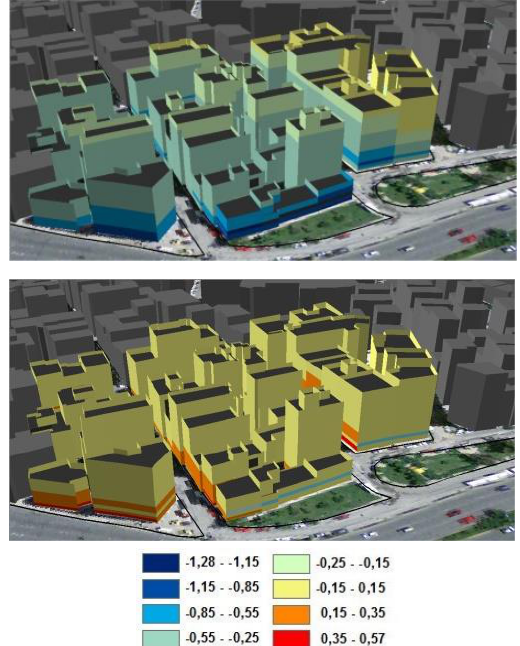
Figure 8: Disturbing temperature on façades between the alternative models (upper – Difference M1-M3), (lower – Difference M1-M2)